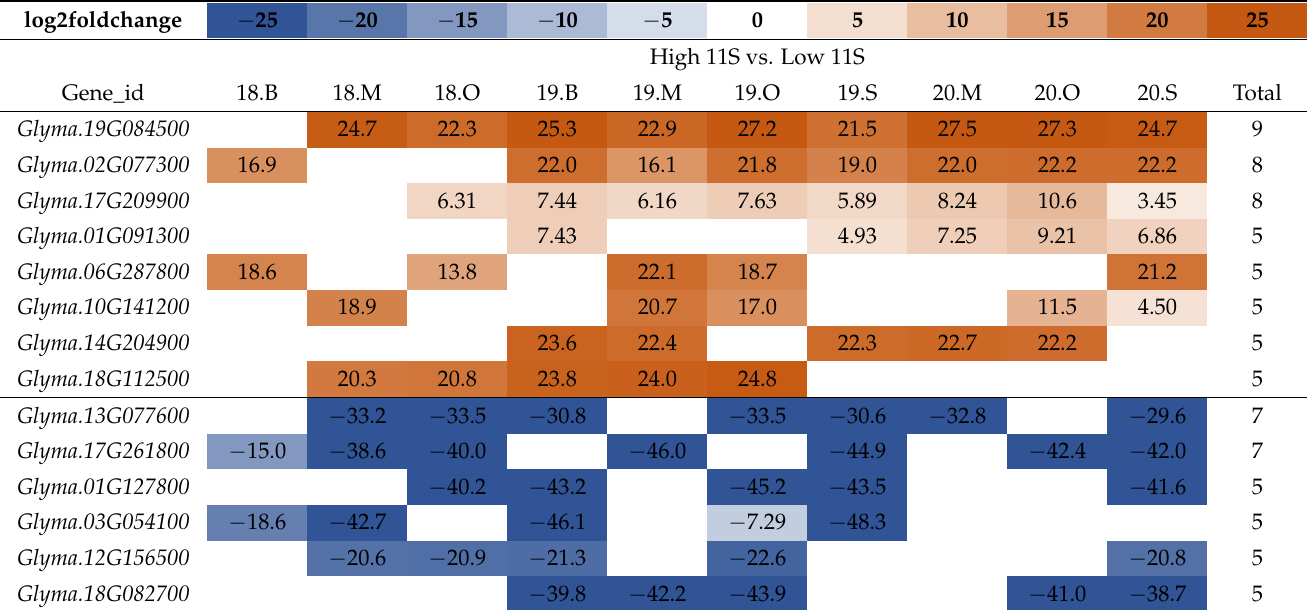
Table 3. log2FC DE between low 11S soybeans (lines 1, 5, 9) and high 11S soybeans (lines 2, 4, 8) from 2018–2020 over 4 different locations. The top 15 most upregulated and 15 most downregulated genes from each DE analysis were selected. Genes are DE in at least 5 of 10 datasets are listed here including the log2FC DE in the high 11S samples. DE datasets are identified by their year-location shorthand; as an example, 18.B indicates DE of high vs. low 11S soybeans in 2018 from Brandon. O, Ottawa; M, Morden; B, Brandon; S, Saskatoon.